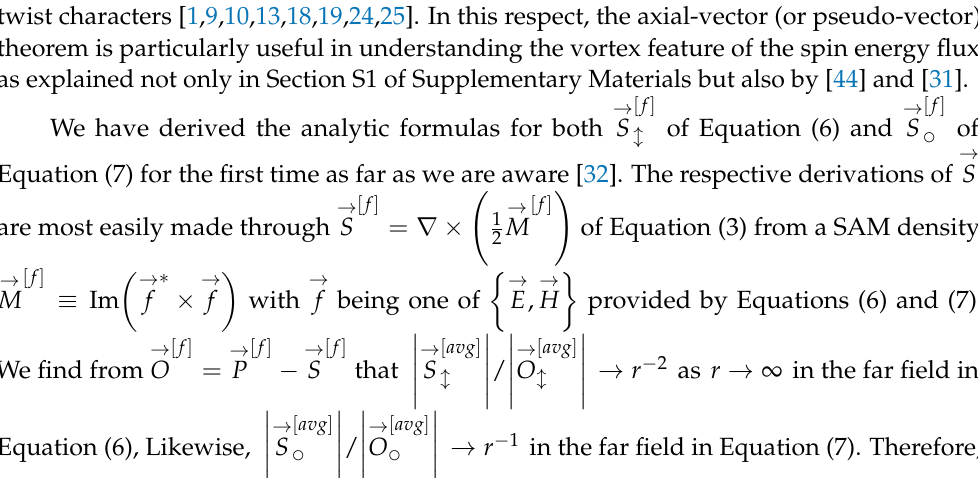
  into an orbital energy flux O and a spin   . Besides, M is a spin angular momentum (SAM) density. ( b ) The coordinate with its dipole axis lying parallel to the vertical axis leads to a pencil-hull-like  with its dipole axis lying on the horizontal plane leads to a filled solid  ○ 